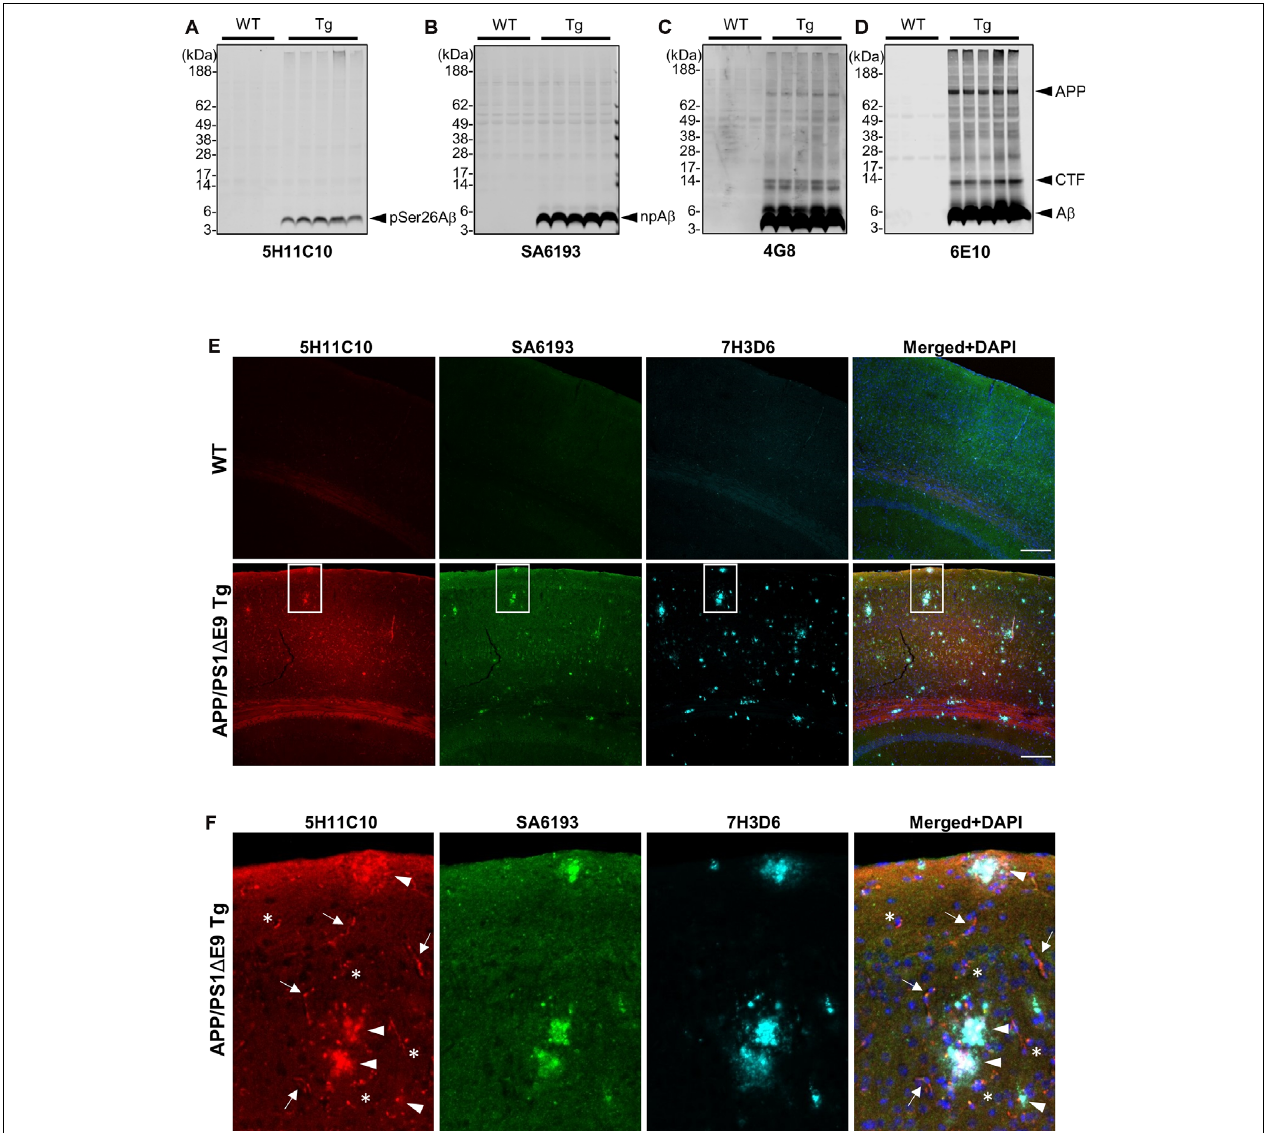
FIGURE 4 | Biochemical and immunofluorescence analysis of pSer26A β in transgenic mouse brain. (A–D) WB analysis of SDS fractions of 12-months-old APP/PS1 ∆ E9 transgenic (Tg) and non-Tg (WT) mouse brain homogenates with 5H11C10 (A) and SA6193 (B) antibodies shows the specific detection of pSer26A β and npA β peptides in vivo . In contrast to 4G8 (C) and 6E10 (D) antibodies, the 5H11C10 and SA6193 antibodies show no reactivity against full-length APP and APP-CTFs in transgenic mouse brain extracts, further demonstrating the specificity of these antibodies for the respective A β peptides with phosphorylated or unphosphorylated Ser26. (E,F) Immunofluorescence analysis of 12-month-old non-transgenic and APP/PS1 ∆ E9 transgenic mouse brain tissues with 5H11C10 and SA6193 antibodies. Representative images showing intraneuronal deposits ( F ; indicated by asterisks), extracellular amyloid plaques ( F ; indicated by arrowheads), and vascular deposition ( F ; indicated by arrows) of pSer26A β peptides. White boxes indicate the area in each image that is shown at higher magnification in enlarged images in panel (F) . Rat monoclonal 7H3D6 antibody, which is highly specific for N-terminally unmodified A β , demonstrates abundant staining of extracellular amyloid plaques, indicating the presence of N-terminally unmodified A β species starting from amino acid Asp1 predominantly in extracellular amyloid plaques ( Supplementary Figure 5 ). Scale bar: 200 µ